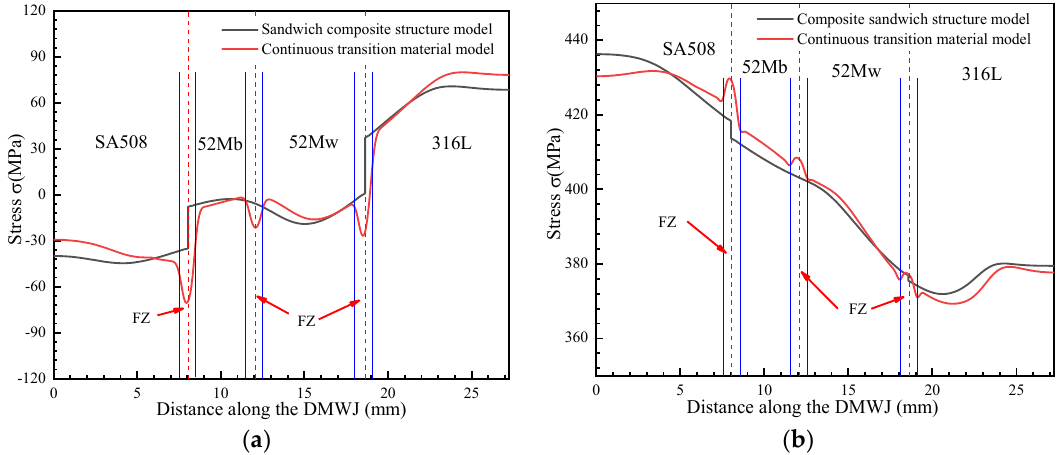
analysis method was the same. In addition, the method proposed in this study can char- acterize the variation of mechanical properties between overlay layers composed of 52Mb and 52Mw. Thus, the method proposed herein is more appropriate for expressing the me- chanical properties in the interface region and better for assessing the structural integrity Figure 11. Z -direction stress under ( a ) an axial load and ( b ) an axial load and internal pipe pressure. of DMWJs. As shown in Figures 12–15, by combining the analysis results for the stress compo- nents in the x -, y -, and z -directions, it was concluded that the sandwich structure model exhibited an abrupt change in stress and in the equivalent plastic strain (PEEQ) in the interface region. This can be attributed to the fact that the model assigns different mechan- ical properties for different partitions, while ignoring the existence of the HAZ and FZ. As shown in Figure 12, the results upon applying the developed continuous transition model revealed that, in the SA508/52M interface region, the stress gradually increased to 485 MPa before gradually decreasing to 405 MPa, whereas in the 52Mw/316L interface region, the stress gradually increased to 450 MPa before gradually decreasing to 376 MPa. In the sandwich structure model, the stress values did not transition continuously in the interface region but instead changed abruptly. This was evident in the sudden stress changes (from 430 MPa to 404 MPa in the SA508/52Mb interface region and from 404 MPa to 377 MPa in the 52Mw/316L interface region). For an internal pressure of 100 MPa, the Figure 12. Stress along the DMWJ under an axial load. The mechanical property variations shown in Figures 12–15 are in general agreement with the room temperature stress–strain results obtained for different regions of welded components in previous studies [3,7,11]. Sudden changes in stress in the interface regions caused subsequent changes in the PEEQ. Therefore, DMWJs possess significant mechanical heterogeneity in multi-material interface regions, and the use of conventional sandwich structure models to study DMWJs may produce nonconservative (unsafe) or overly conser- vative results. Consequently, the mechanical property distributions for DMWJ interface regions must be treated properly when assessing the structural integrity of